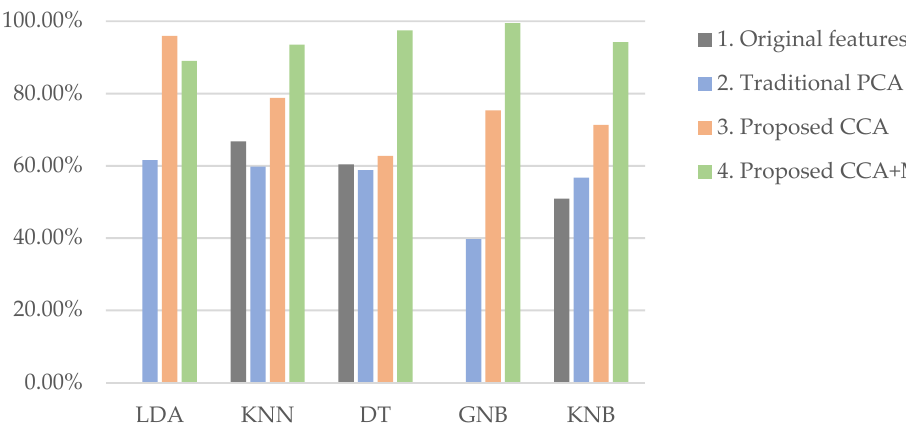
Figure 11. Comparison chart related to the performance index obtained using the original features, the reference DRM and the proposed one (showing partial result of each phase) as the type of classifier varies.